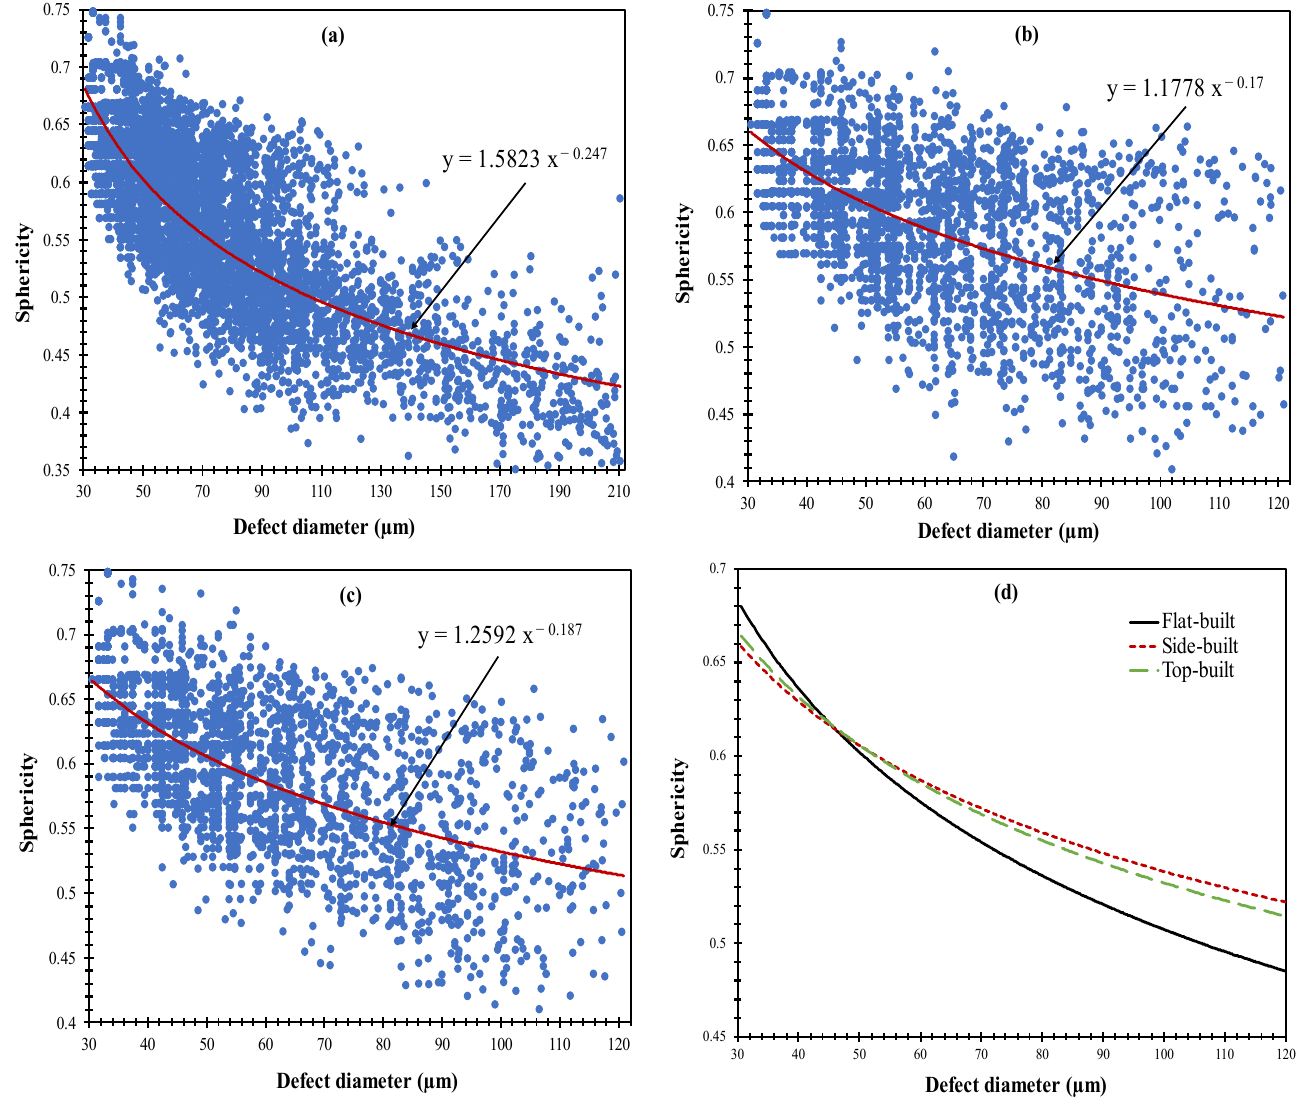
Figure 6. The scatter distribution of sphericity with increasing defect diameters of ( a ) flat-built, ( b ) side-built, and ( c ) top-built samples, along with ( d ) the comparison of the trendlines of the sphericity distribution among the three samples.